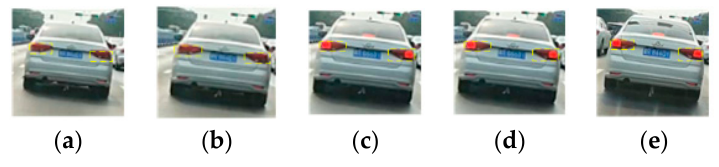
Figure 15. The change of the vehicle’s brake lights.